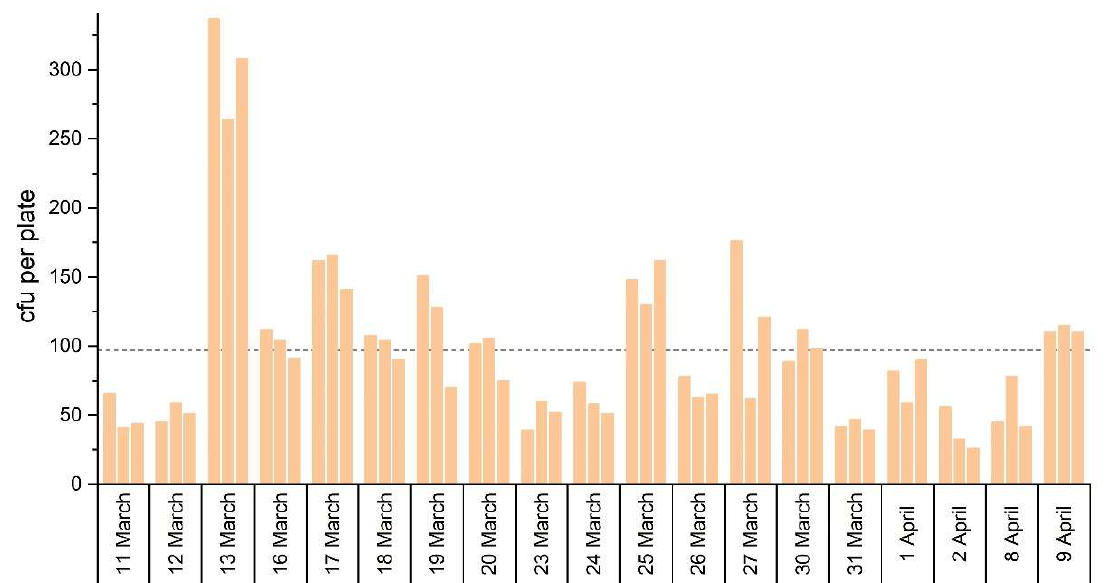
Figure 2. Total colony-forming units (cfu) counts per plate of all control runs held between the main runs once a day over the entire experimental period. Fungi were counted after 24, 48, and 72 h of incubation at room temperature on Potato Dextrose Agar (PDA). Each bar represents one of the three counted trap plates from the Air Sampler Box (ASB) with the corresponding total cfu. The mean cfu was 97 cfu per plate (dotted line) over the testing period.